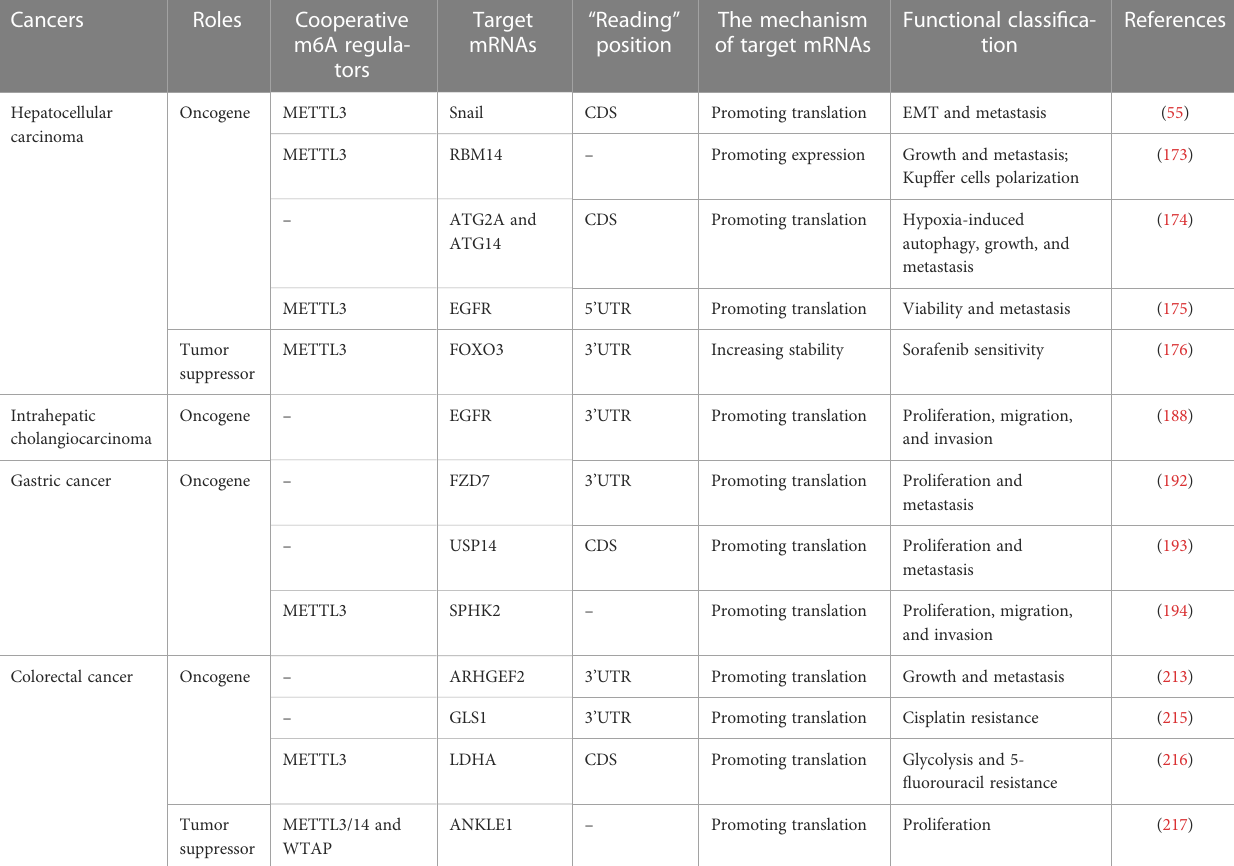
TABLE 1 The role of the YTHDF1 in